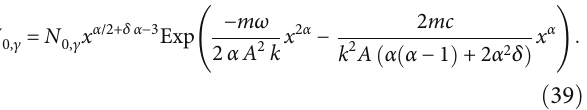
Table 6: charm and beauty baryon masses in ground state (masses are in GeV) at ( α = β